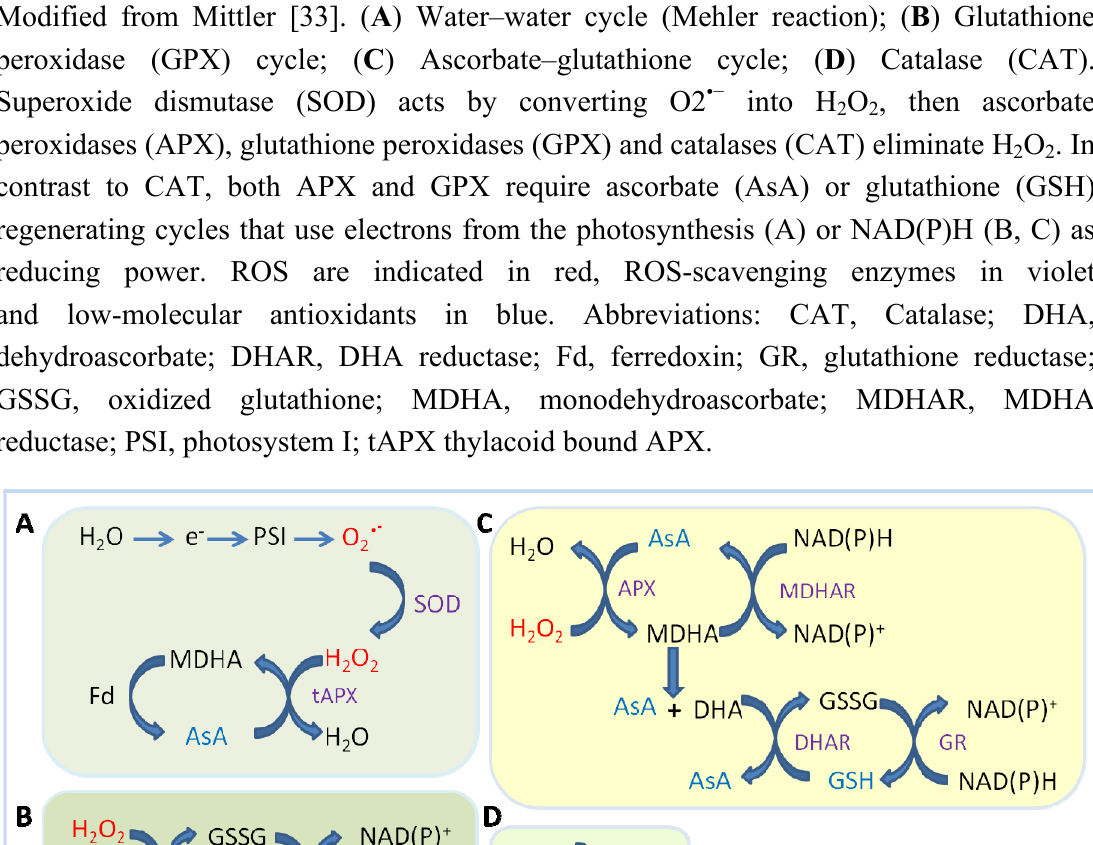
Figure 2. Different pathways for reactive oxygen species (ROS) scavenging in